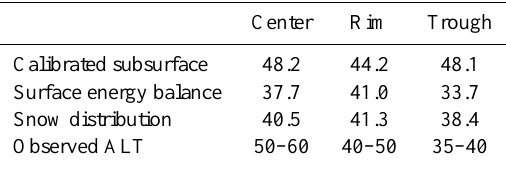
Table 4. The ALT for all three columns are listed for each iteration of the calibration process, also with the range of possible ALT from the observed data. The observed ALT range was made by finding the deepest borehole measurement for center rim and trough with a temperature above 0 ◦ C for at least a day and the shallowest bore- hole measurement with all temperatures below 0 ◦